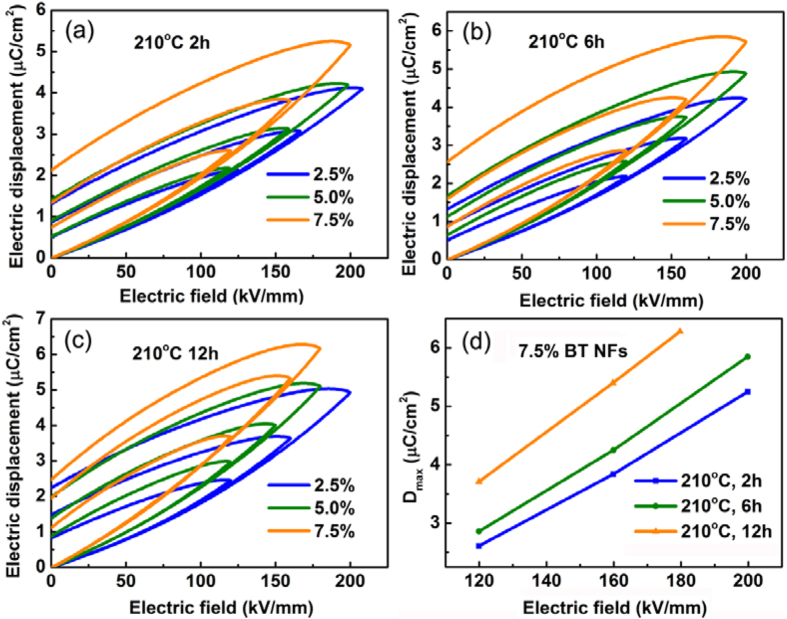
The D-E loops of nanocomposites where the volume fraction of BaTiO3 NFs ranged from 2.5% to 7.5% and the aspect ratio (AR) of BaTiO3 NFs was (a) 210 °C 2 h; AR = 3.5, (b) 210 °C 6 h; AR = 7.4, and (c) 210 °C 12 h; AR = 21.0. (d) The Dmax of the nanocomposites with electric field for 7.5 vol% BT NFs with various aspect ratios.